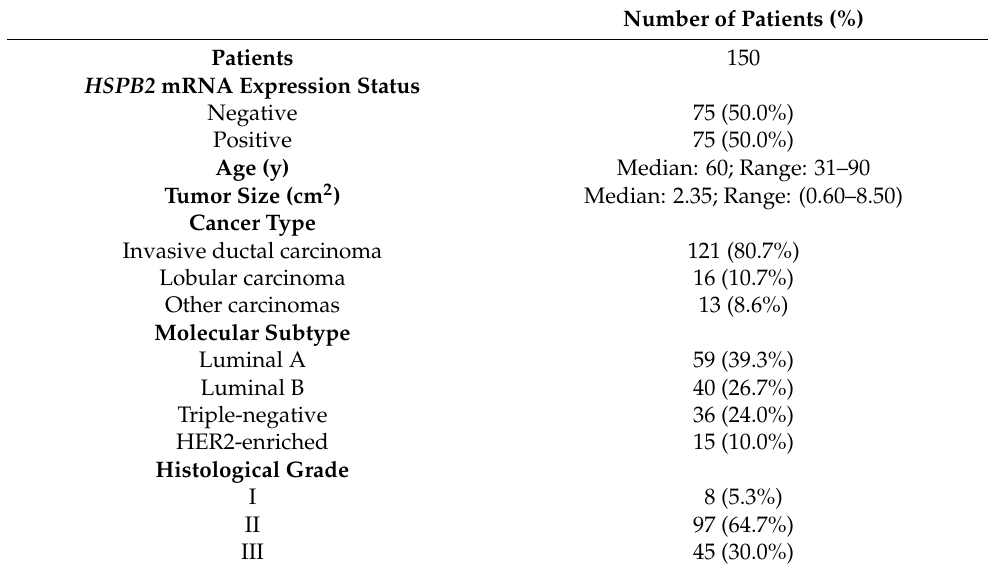
Table 1. Clinicopathological features of BrCa patients.